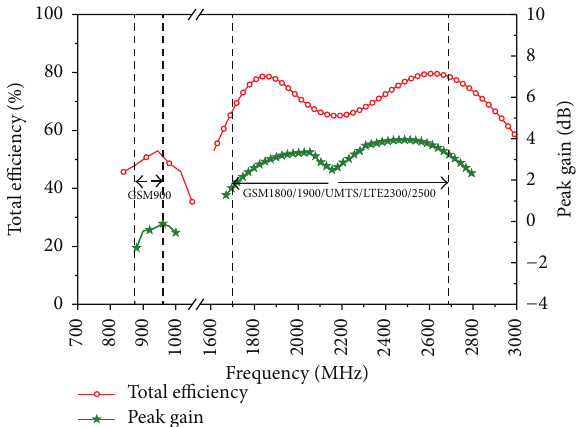
Figure 5: Measured total efficiency and peak gain of the proposed